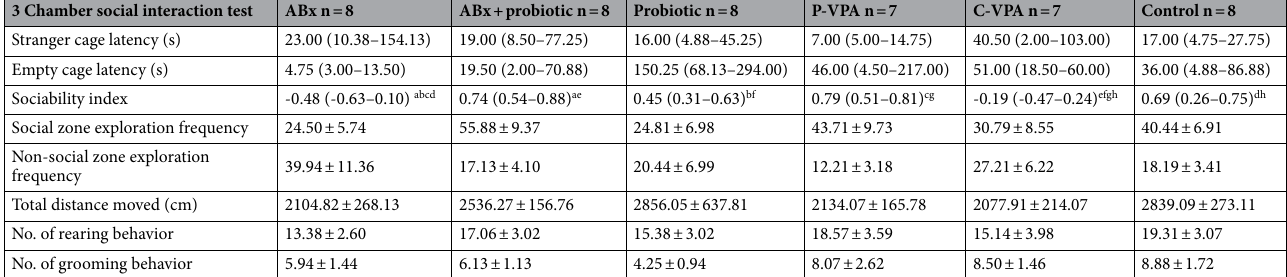
Table 1. Three chamber social interaction test. ABx: broad-spectrum antibiotics treated group, ABx + probiotic: broad-spectrum antibiotics- and probiotic treated group, Probiotic: probiotic treated group, P-VPA: valproic acid and probiotic treated group, C-VPA: valproic acid treated group, Control: control group. Values of the stranger cage latency, the empty cage latency and sociability index are median (IQR) and the social- and non-social zone exploration frequency, total distance moved values, number of raring behavior and number of grooming behavior are means and SEMs. One-way ANOVA, Kruskal–Wallis test and